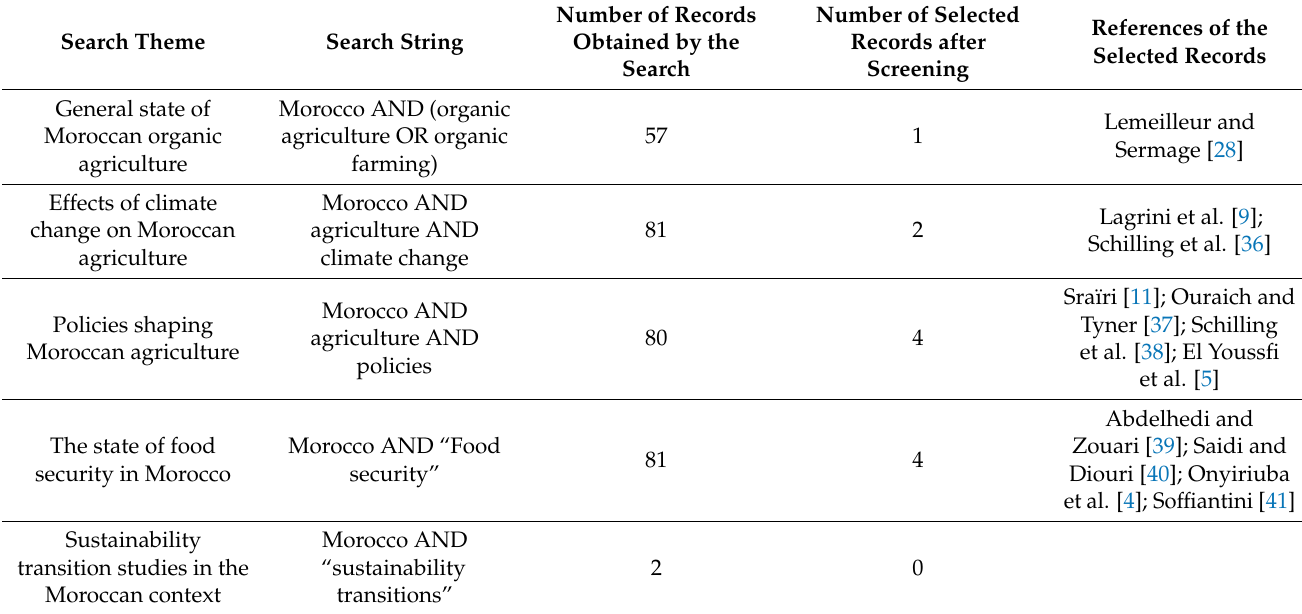
Table 1. Summary of the literature review of the Web of Science